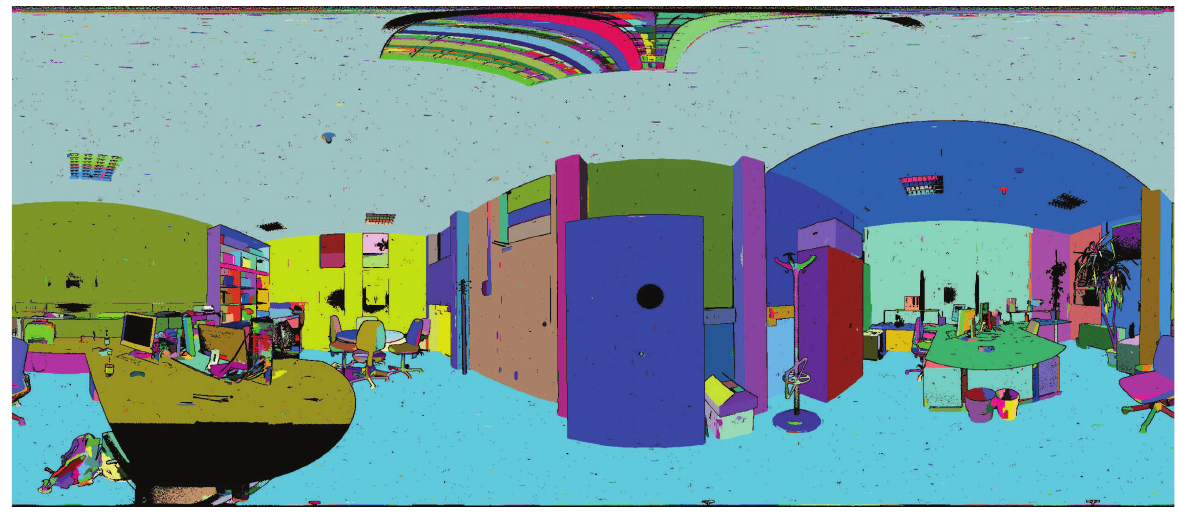
Figure 8: Segmentation results of the proposed method on the stationary indoor test data with θ = 20 . 0 ◦